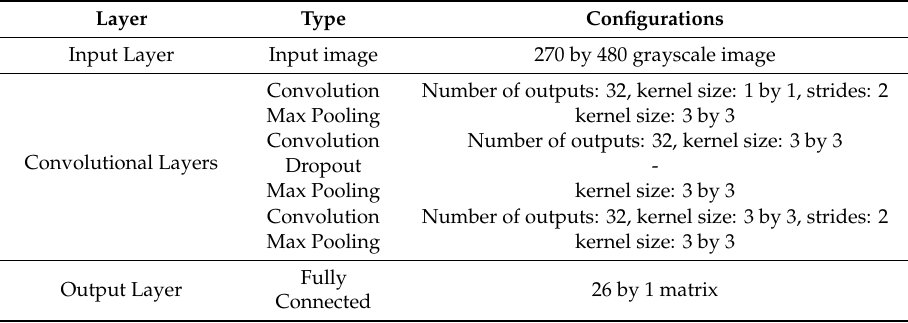
Table 1. Components of the CNN model.